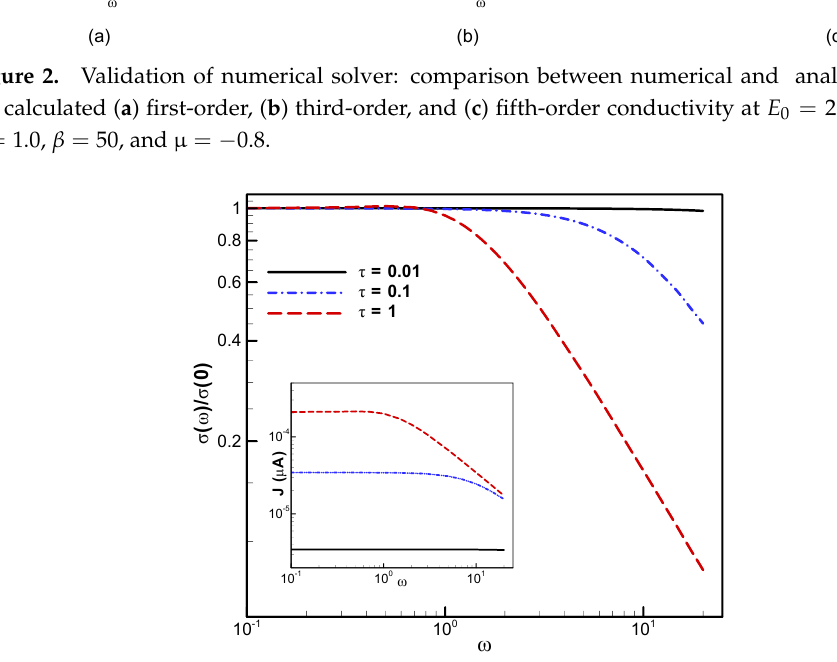
Figure 3. Computed electrical conductivity for three different relaxation times τ = 0.01,0.1, and 1 at E 0 = 10 4 V/cm, β = 50, and µ = −